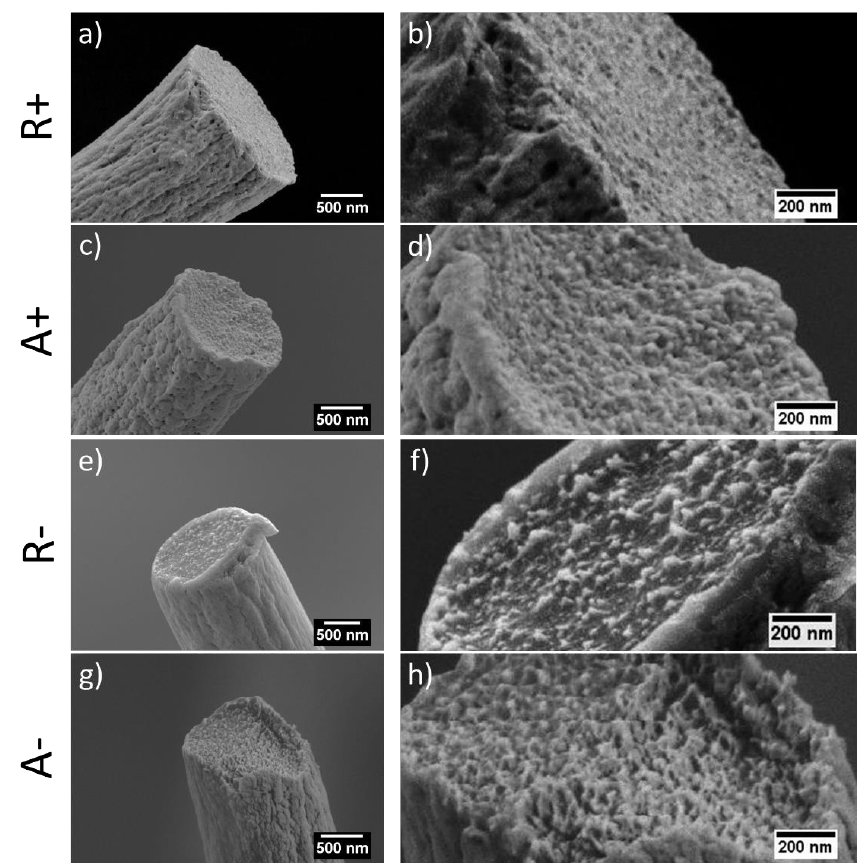
Figure 4. High-resolution scanning electron microscopy (SEM) micrographs of cross-sections of PMMA electrospun fibers produced with a positively (+) ( a – d ) or negatively (−) ( e – h ) charged spinneret. Fibers were deposited randomly (R) and aligned (A) on the